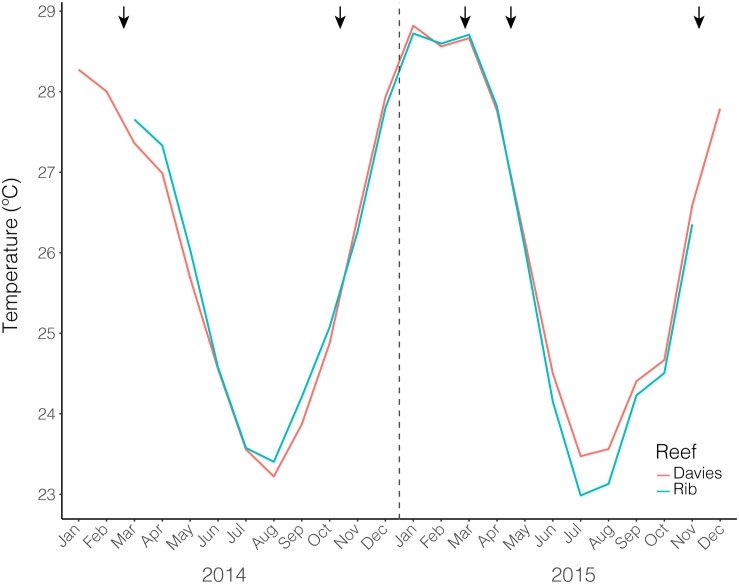
Average monthly temperatures from both Rib and Davies reef from January 2014 – December 2015. Black arrows indicate sampling time points.